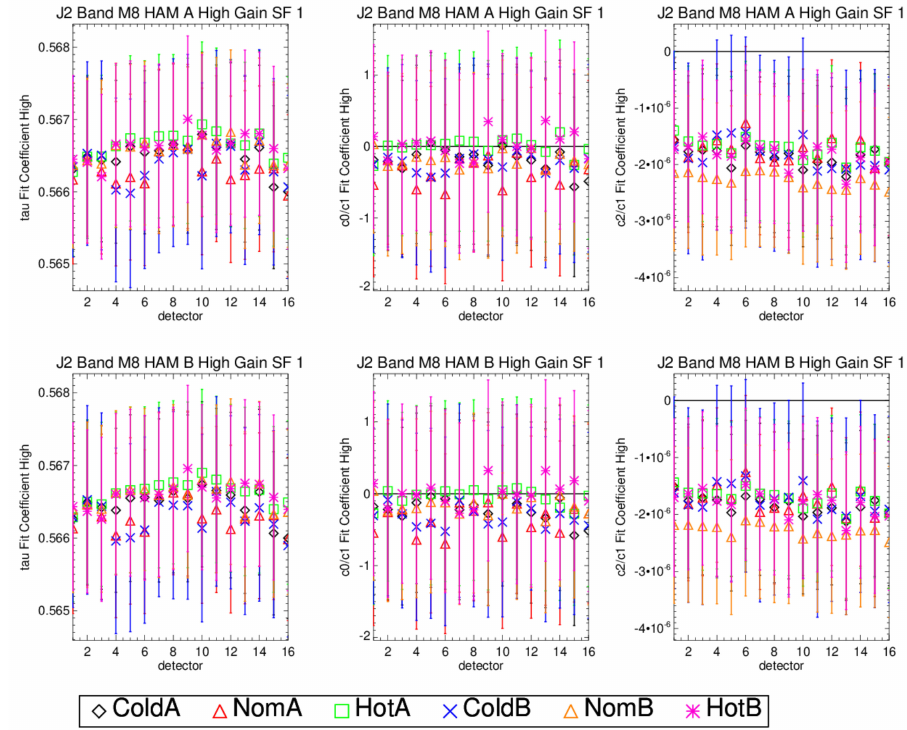
Figure 10. Band M8 fit coefficients for all detectors (x-axis) and TVAC/electronics configurations (colors and symbols). The columns are tau, c 0